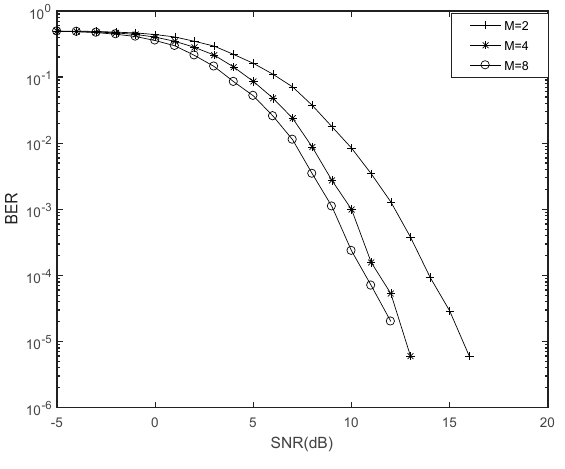
Figure 8. BER in different M .